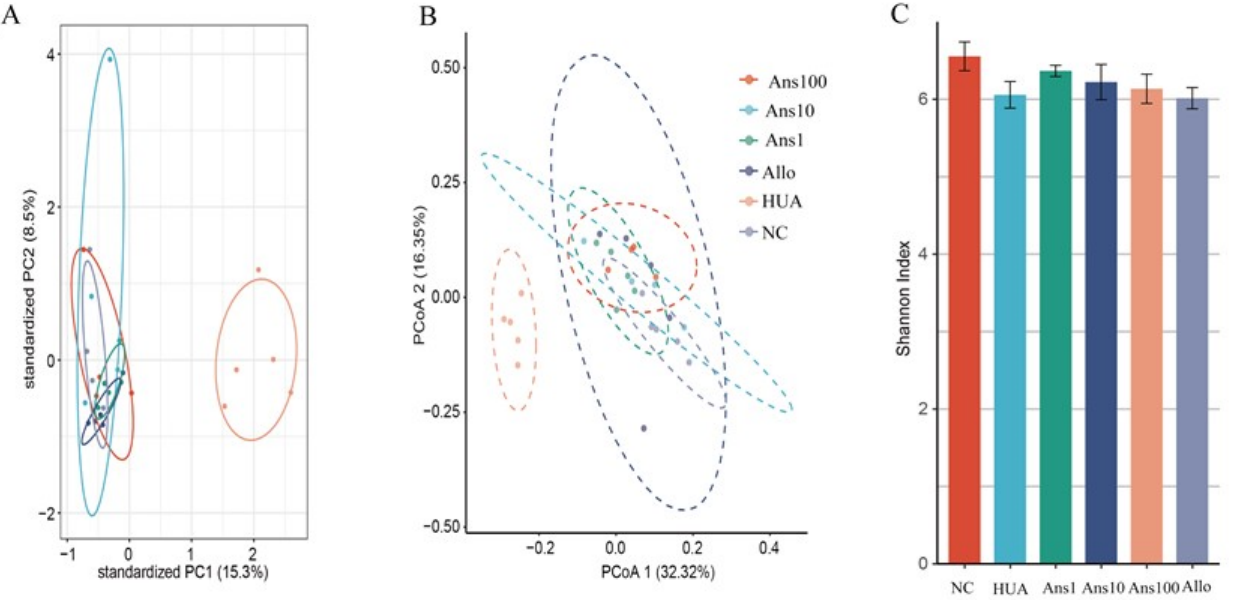
Figure 5. Effect of anserine on the gut microbiota structure and diversity: ( A ) PCA, ( B ) PcoA, and ( C ) Shannon index ( p < 0.05). (“Ans100” refers to “Anserine 100 mg group”; “Ans10” refers to “Anserine 10 mg group”; “Ans1” refers to “Anserine 1 mg group”; “Allo” refers to “Allopurinol group”; “HUA” refers to “hyperuricemic group” “NC” refers to “Normal control